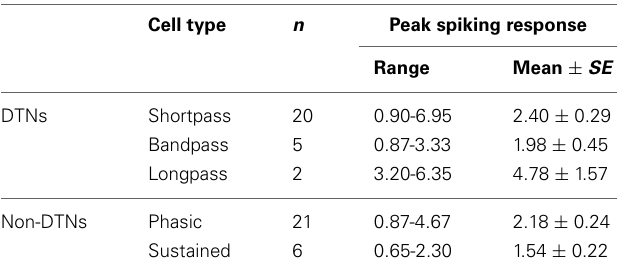
Table 2 | Range and average peak spike counts (spikes per stimulus) for cells tested with ILD stimuli at + 10dB above